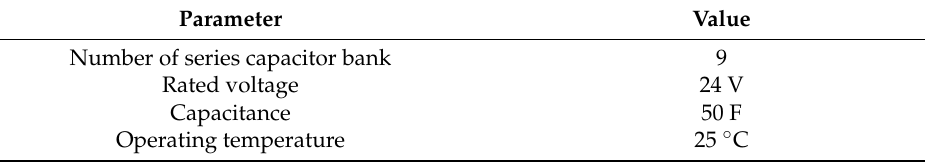
Table 9. SC bank parameters.